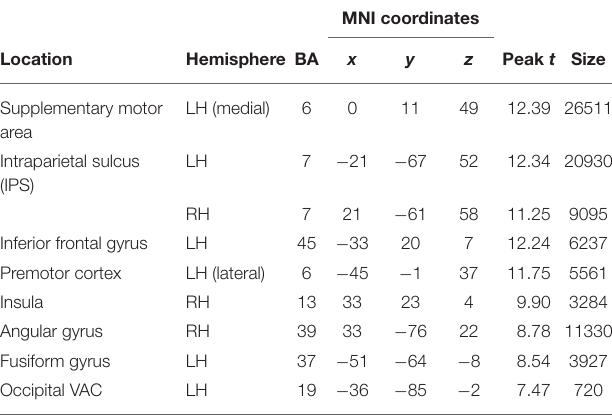
TABLE 1 | Cluster location and peaks across age groups (RF + RS >